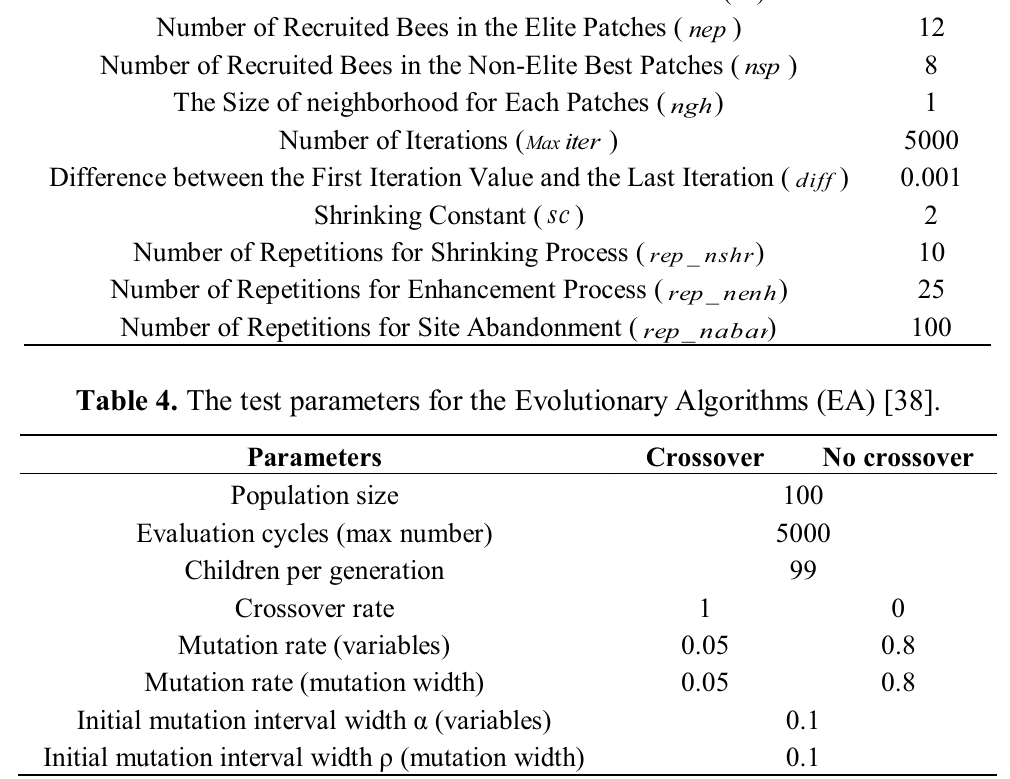
Table 3. The best test parameters for the BA after parameter tuning. Parameters Value Number of Scout Bees in the Selected Patches ( n ) 50 Number of Best Patches in the Selected Patches ( m ) Number of Elite Patches in the Selected Best Patches ( e ) Number of Recruited Bees in the Elite Patches ( nep ) The Size of neighborhood for Each Patches ( ngh )